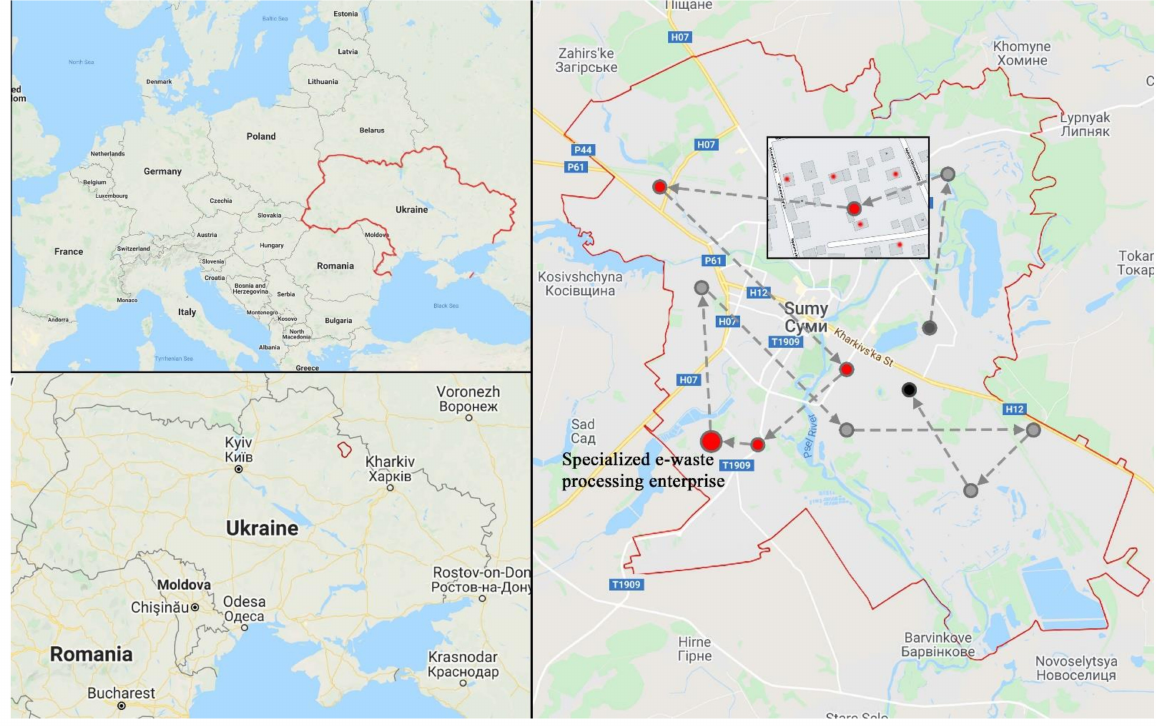
Figure 2. E-waste collection interactive online map with the conditional route of the delivery service’s vehicle, Sumy city,